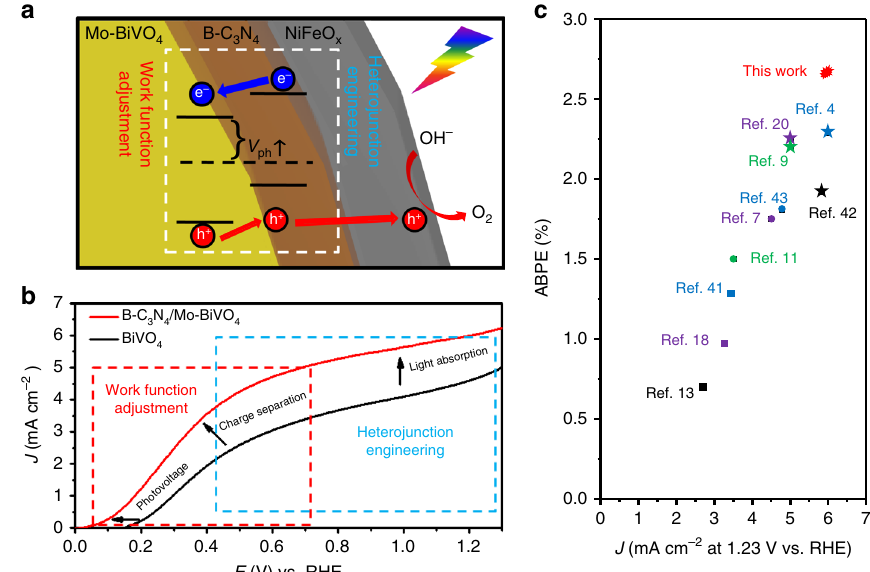
Fig. 6 Photoelectrochemical water splitting characterization. a Schematic diagram illustrating the separation of photo-generated electrons and holes of the NiFeO x /B-C 3 N 4 /Mo-BiVO 4 photoanode, b LSV curves of pure-BiVO 4 , B-C 3 N 4 /Mo-BiVO 4 recorded at a scan rate of 25 mV s − 1 under AM 1.5 G one-sun irradiation in PPB solution using 0.5 M Na 2 SO 3 as a hole scavenger (pH 7), c speci fi c photocurrent density at 1.23 V vs. RHE and applied bias